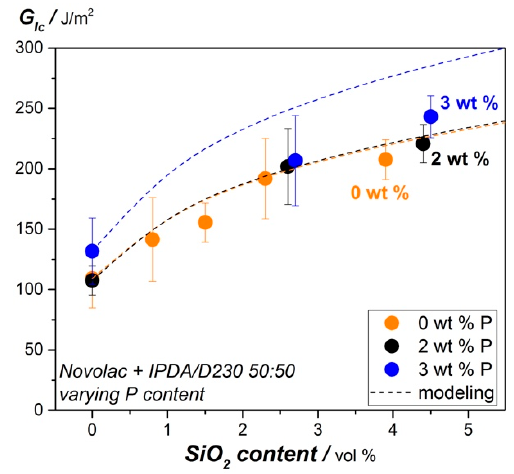
Figure 7. Fracture toughness of the tested material systems.